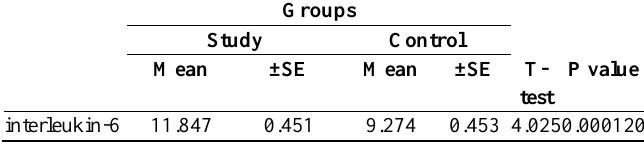
Table 3: Mean values and statistical difference of salivary interleukin-6 among the study and control groups